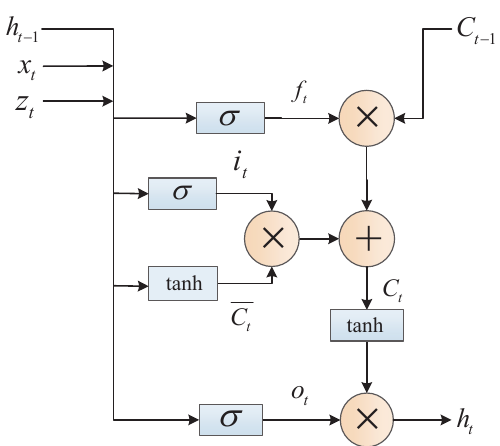
Figure 2. The structure of LSTM network. The input of the neuron is composed of x t and z t , x t represents the traffic flow data of the current node, and z t represents the characteristic of the traffic flow data of the upstream and